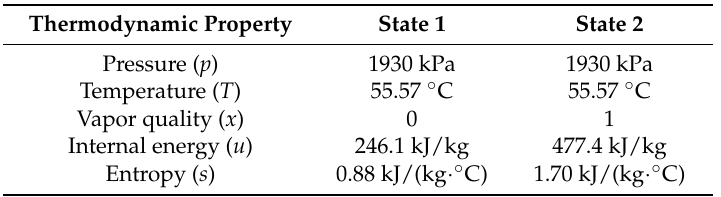
Table 2. Thermodynamic properties of Propane